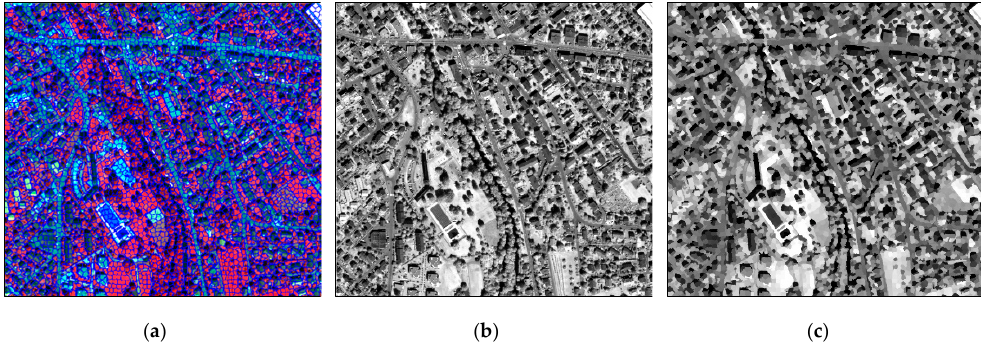
Figure 6. The segmentation result in ( a ) and guidance images for comparison purposes: ( b ) in the original pixel-based GF and ( c ) in the proposed superpixel-based GF (Zh2).